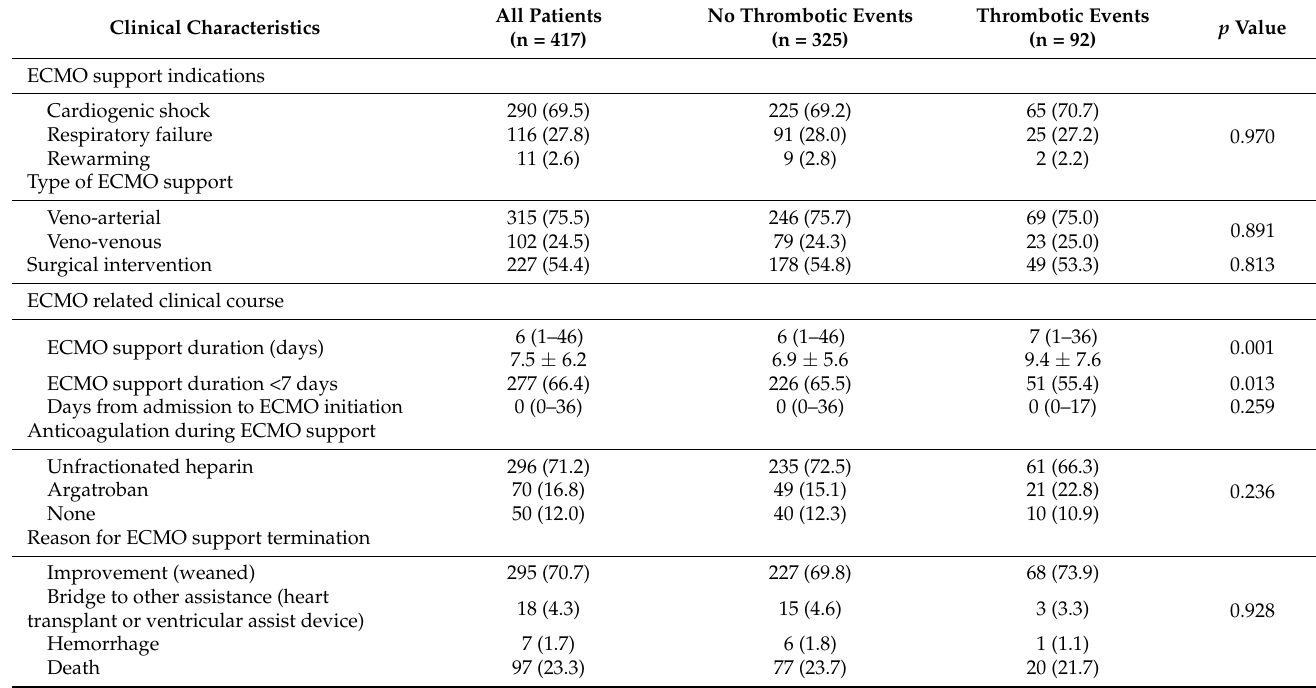
Table 2. ECMO-related characteristics and outcomes according to the occurrence of thrombotic events (n = 417).